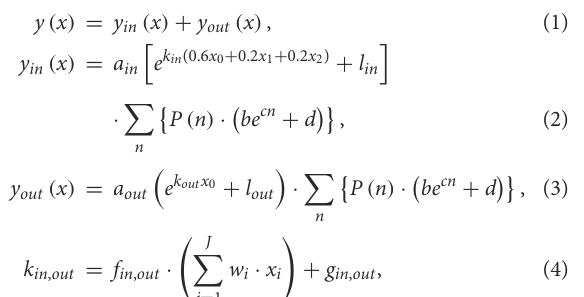
TABLE 2 Percentage of heat illness patients transported from indoor/home and outdoor/workplace from June 1 to September 30 from 2017 to 2019.